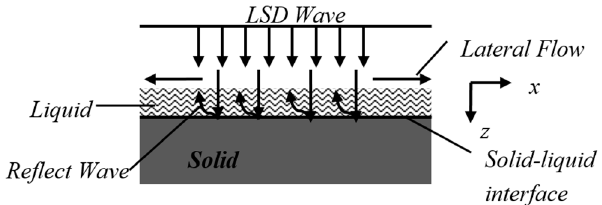
Figure 3. Interactions of the silicon melting layer and solids by LSD wave.